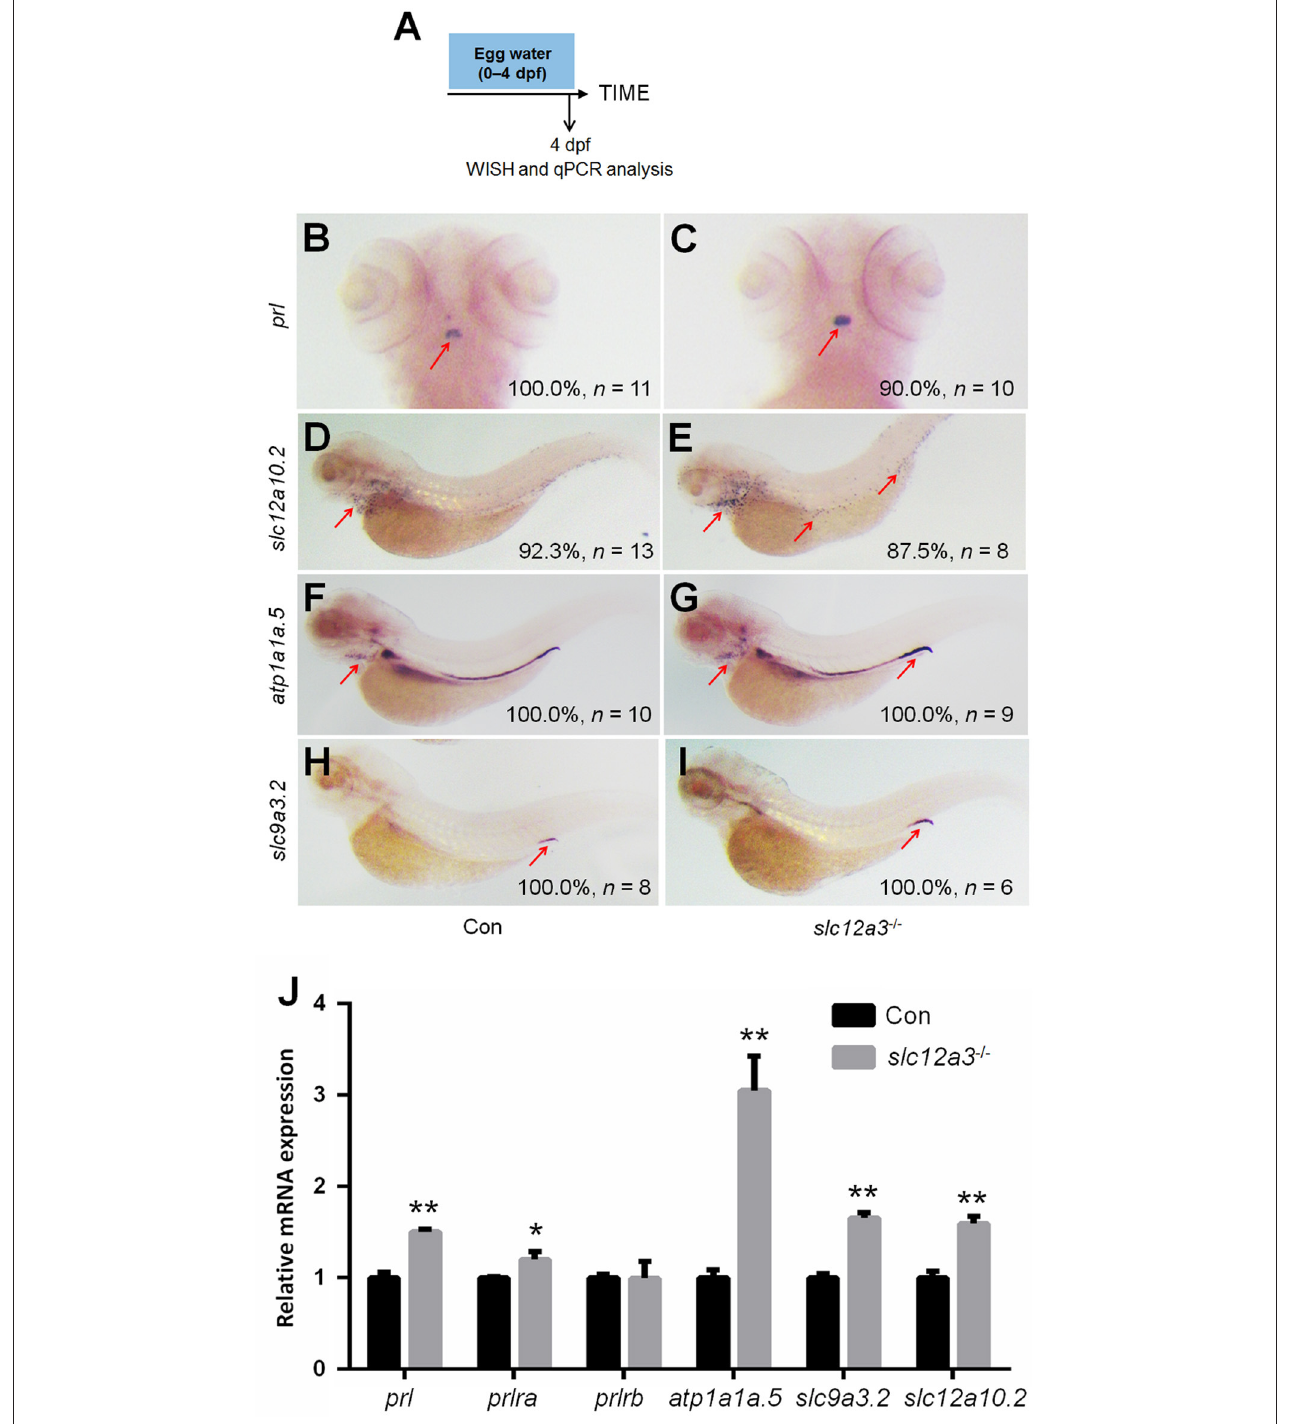
FIGURE 6 | Expression patterns of prl and PRL targets in the slc12a3 -deficient larvae at 4 dpf. (A) Schematic diagram of the rearing timeline. Larvae were harvested at 4 dpf for WISH analysis. (B,C) WISH analysis using the probe of prl in control and slc12a3 -deficient larvae at 4 dpf. (D,E) WISH analysis using the probe of slc12a10.2 in control and slc12a3 -deficient larvae at 4 dpf. (F,G) WISH analysis using the probe of atp1a1a.5 in control and slc12a3 -deficient larvae at 4 dpf. (H,I) WISH analysis using the probe of slc9a3.2 in control and slc12a3 -deficient larvae at 4 dpf. Red arrows indicate the expressions of the nominated genes. (J) Expression levels of prl , prlra , prlrb , atp1a1a.5 , slc9a3.2 , and slc12a10.2 in control larvae and slc12a3 -deficient larvae at 4 dpf were examined with qPCR assay. * P < 0.05. ** P < 0.01.